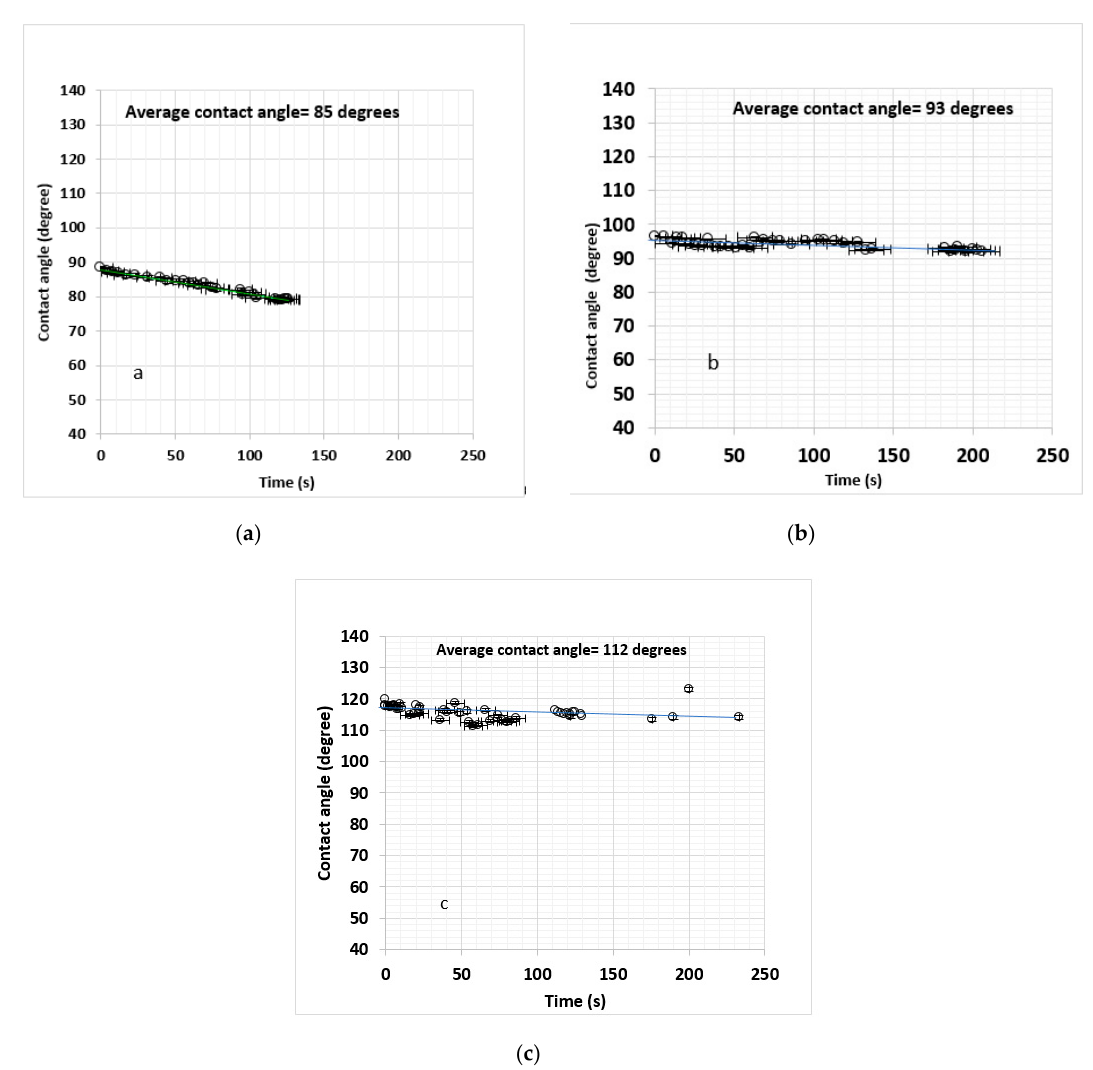
Figure 3. Contact angle of water droplet on calcite, the surface of which was modified by stearic acid in an n -decane model oil containing: ( a ) 0.001 M stearic acid; ( b ) 0.005 M stearic acid; and ( c ) 0.010 M stearic acid.